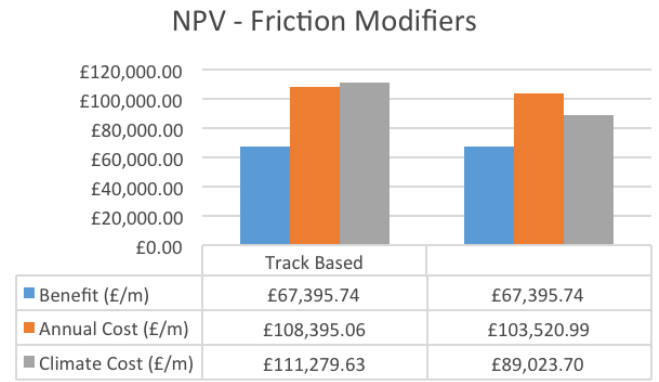
Figure 7. Net present values for two categories of friction modifiers.